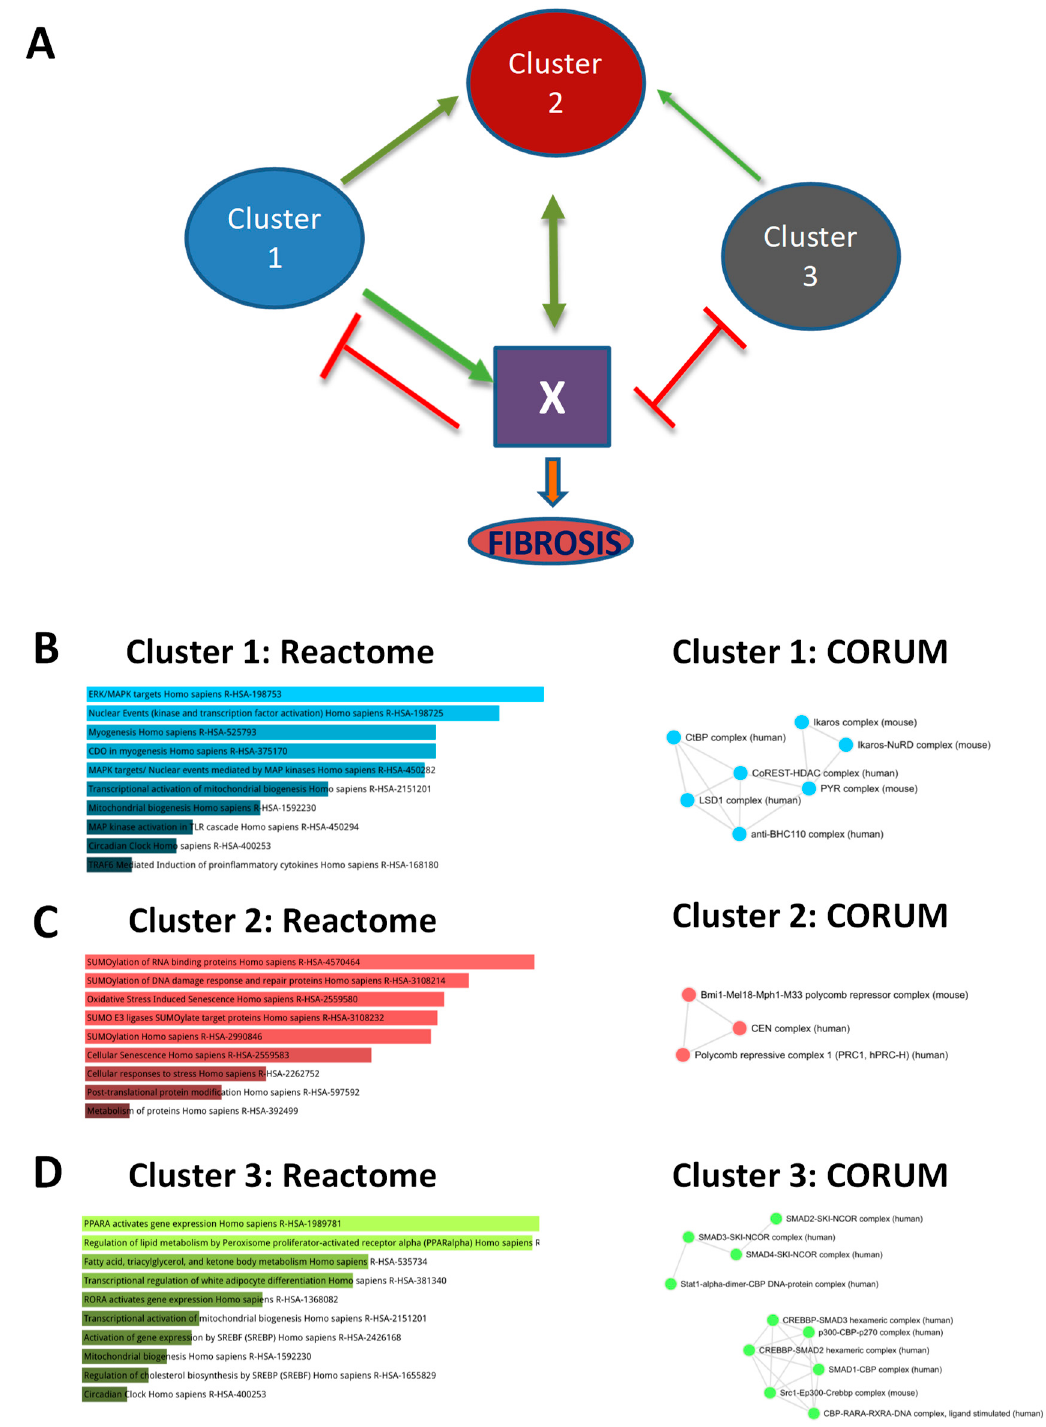
Figure 6. Hypothetical model depicting possible mechanisms of liver fibrosis. ( A ) diagrammatic representation of the proposed dynamic interplay among transcriptional modules during fibrosis. Green and red arrows represent positive and negative regulatory effects, respectively. Clusters 1, 2 and 3 represent groups of transcriptional modules as demonstrated in Figure 5D. ( B – D ) enriched pathways from Reactome ( left panels ) and protein–protein interactions from CORUM ( right panels ) for cluster 1 ( B ), cluster 2 ( C ) and cluster 3 ( D ) transcription factors. Enrichment analysis was performed on Enrichr.